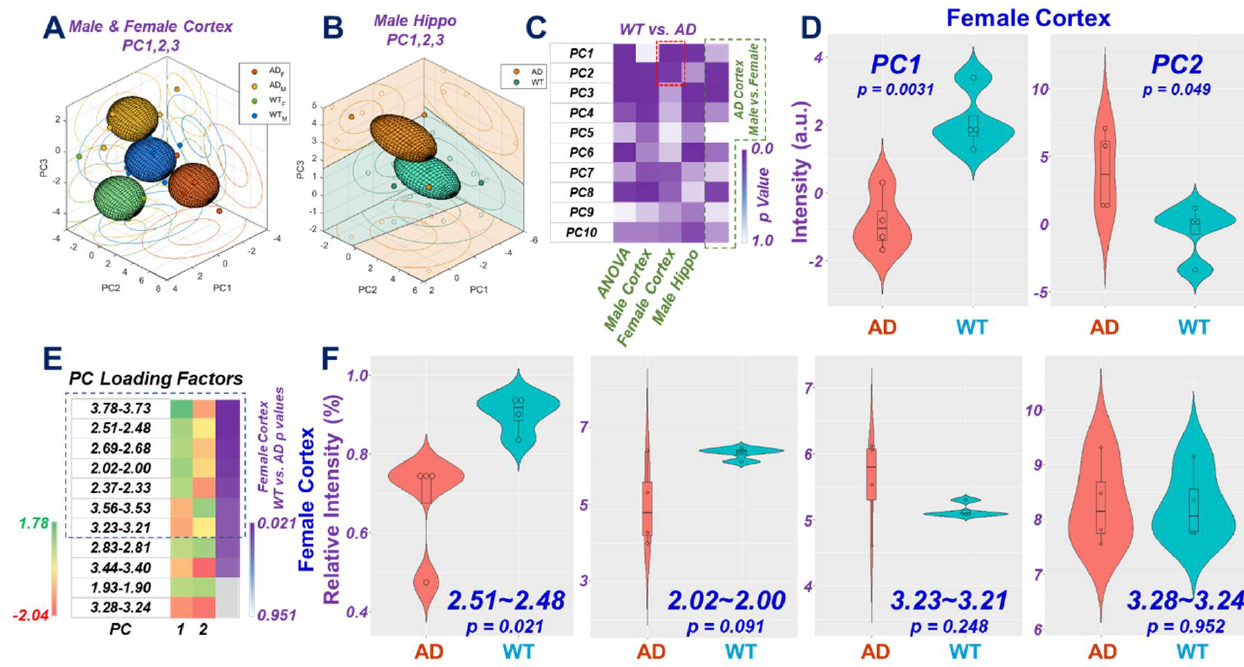
Figure 5. Differentiations of AD from WT using Tissue metabolomics Profiles Measured from Different Brain Regions. Three-dimensional plots of PC1, PC2, and PC3, for ( A ) cortex of female and male and ( B ) hippocampus of male animals. The 3D ellipsoids generated from these PCs that cover the volume of 3D Mahalanobis distance ≤ 1 (one standard deviation from the centroid along each axis) from the class means for AD and WT groups, according to the covariance matrix of all class-mean-corrected samples. Group separations are clearly presented in these plots; ( C ) p -values for differentiations between AD and WT for the tested groups; ( D ) examples of differentiating AD from WT by using PC1 and PC2 calculated from female cortex. A revisal of correlations is seen with these two PCs; ( E ) 11 of the 42 analyzed female cortex spectral regions appeared as common regions in either the top or the bottom 50% of major contributing spectral regions towards the determinations of PC1 and PC2. These regions are listed (in ( E )) in ascending order according to the p -values of the spectral regions in comparing AD from WT (coded in purple). Green color indicates the region’s positive contribution towards the final PC values, and red color a negative contribution; ( F ) examples of individual regions seen in ( E ), where small p -values corresponding to large color differences between green and red (cf. 2.51~2.48) that translate to polar contributions to the PC values, and large p -values corresponding to small color differences (cf. 3.28~3.240), contribute non-polarly to the PC values.